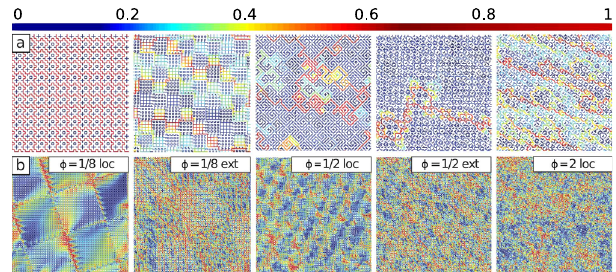
Fig. 2 Quasiperiodic composite microgeometry and Anderson localization of fi elds. Moiré interference patterns generated by the transformation Eq.